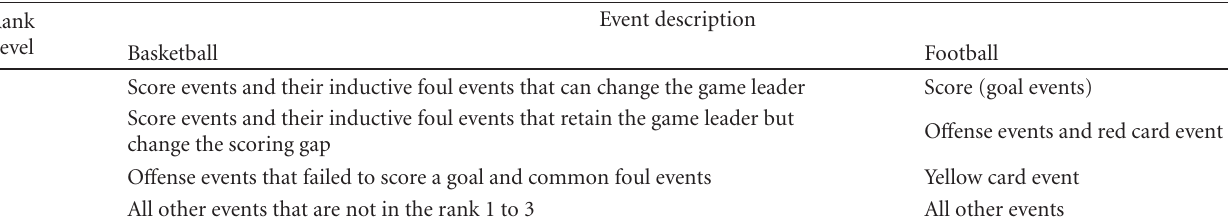
Table 4: Event importance rank